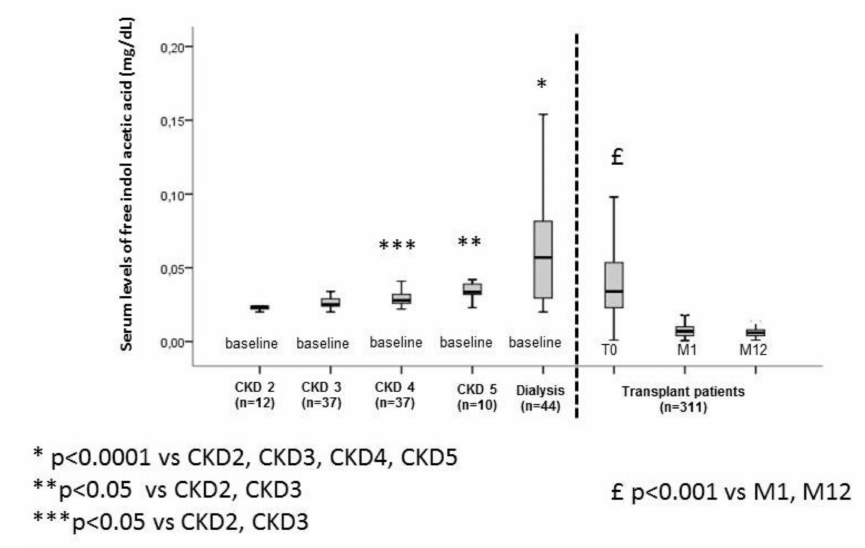
Figure 1. Serum levels of free indole acetic acid in a non-transplanted chronic kidney disease (CKD) cohort and a transplanted cohort. Boxplot with whiskers with maximum 1.5 interquartile range.